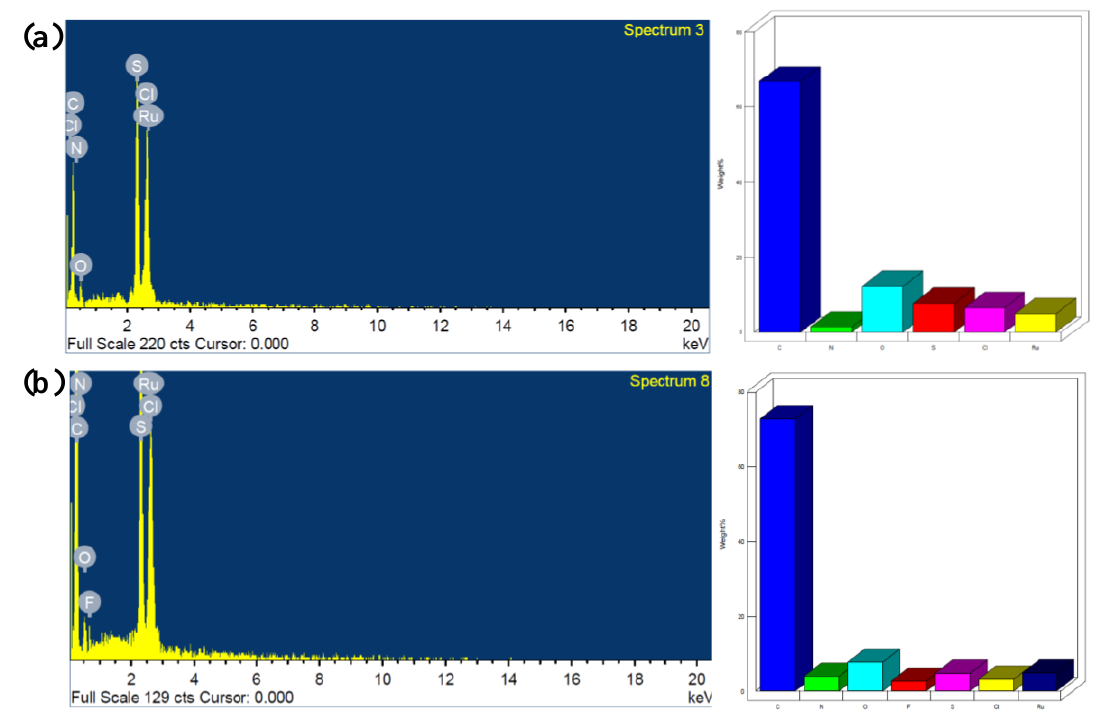
Figure 5. EDX images of ( a ) GO-NCD- 1 and ( b ) GO-NCD- 2.